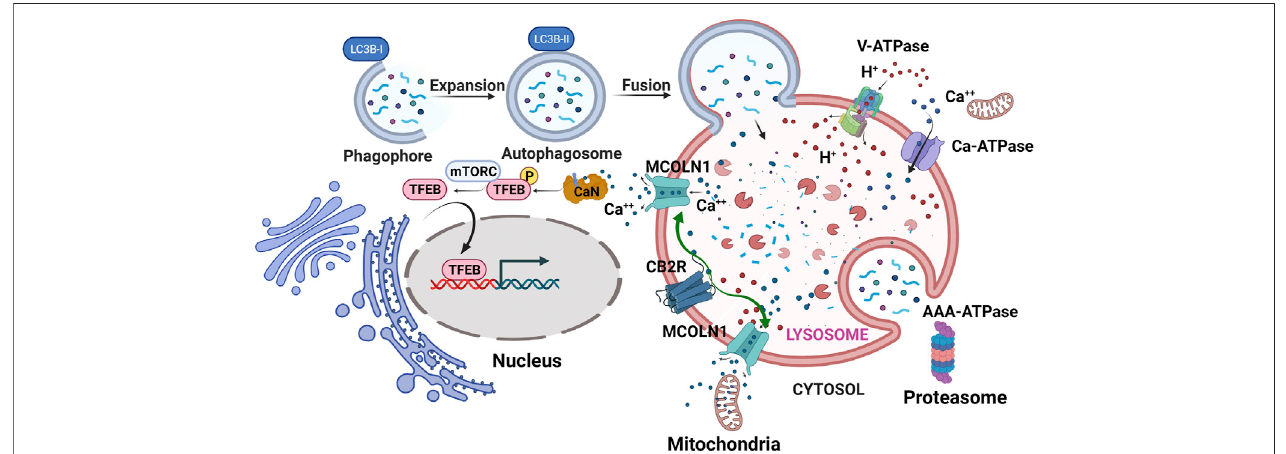
FIGURE 6 | CB2R pro-autophagy effect. Lysosomal CB2R activation results in release of intra-lysosomal Ca 2+ through MCOLN1 (Mucolipin TRP Cation Channel 1). Thereleased Ca 2+ tethersmitochondria tolysosomesandsomeCa 2+ ionsaretransferred tothemitochondriawhere lessROSisthen produced. Calcineurin(CaN)is also activated that then dephosphorylates TFEB causing its translocation to nucleus, downstream of which autophagosomes and lysosomes are generated. Green arrows represent CB2R stimulation of MCOLN1 to release Ca 2+ ions that enter mitochondria and activate calcineurin (CaN) for TFEB nuclear translocation. V-ATPase, vacuolar-type ATPase; Ca-ATPase, Calcium ATPase; AAA-ATPase, ATPases Associated with diverse cellular